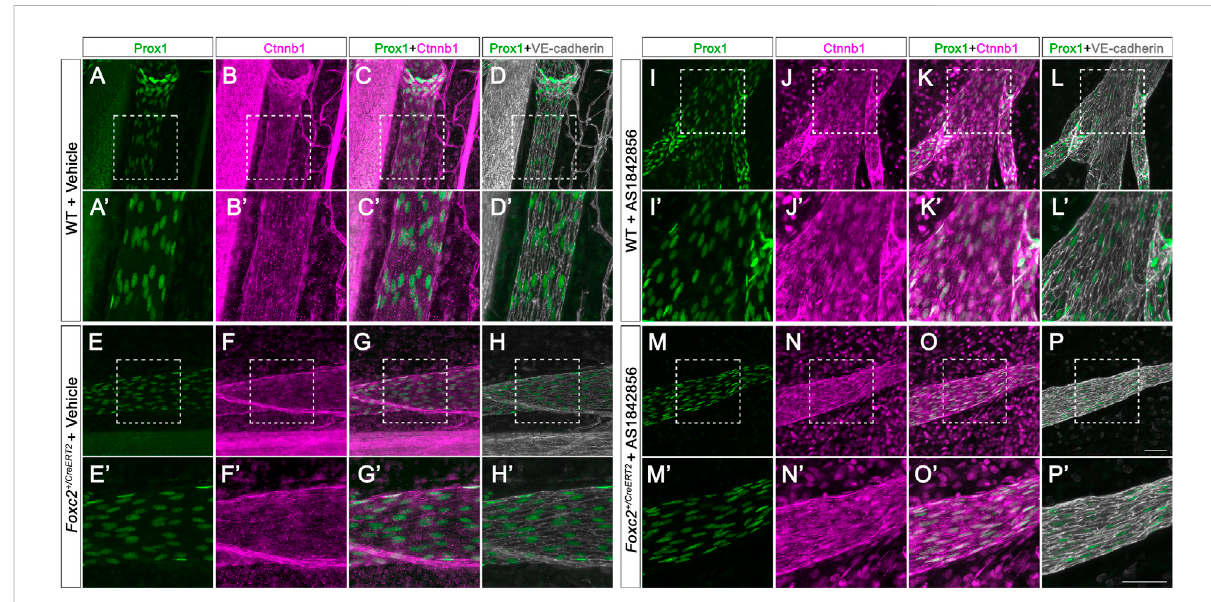
FIGURE 4 AS1842856 injection promotes β -catenin nuclear localization in vivo . (A – P 9 ) Whole-mount immunostaining of P11 mesenteric collecting lymphatic vessels from wildtype and Foxc2 +/CreERT2 pups with vehicle control (DMSO) or AS1842856 injection. Prox1 is shown in green, Ctnnb1 in purple, and VE-cadherin in gray. (A 9 – P 9 ) shows higher magni fi cation images of the white box areas (A – P) . Scale bars are 100 μ